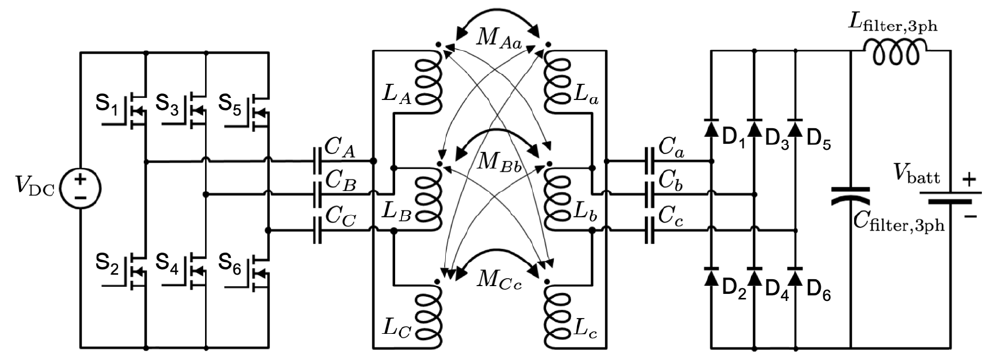
Figure 4. Equivalent electric scheme of the WPT system and its final